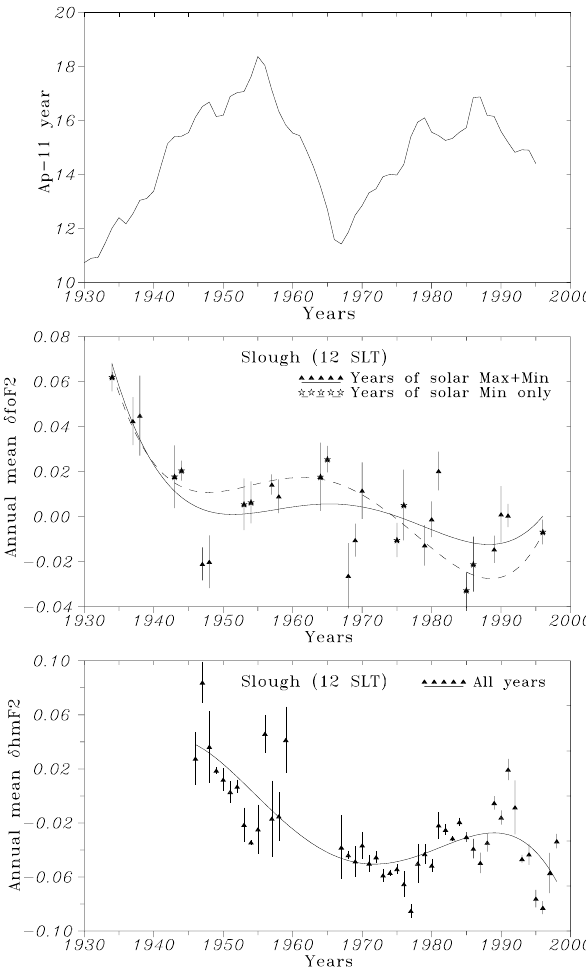
Fig. 9. 11-year running mean Ap index along with δ fo F2 and δ hm F2 long-term variations. Two year selections ( M + m ) and (m) (see text) are used for the fo F2 and (all years) for the hm F2 trend analy- sis. Least squares fitting curves are a 4th degree polynomials. Error bars present the standard deviation of seasonal (over 12 months)